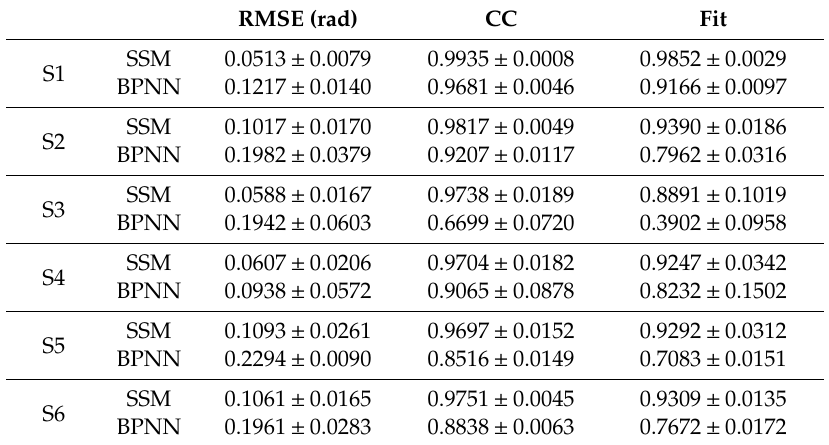
Table 1. Values of RMSE, CC and FIT of di ff erent models in terms of joint angle prediction for all the